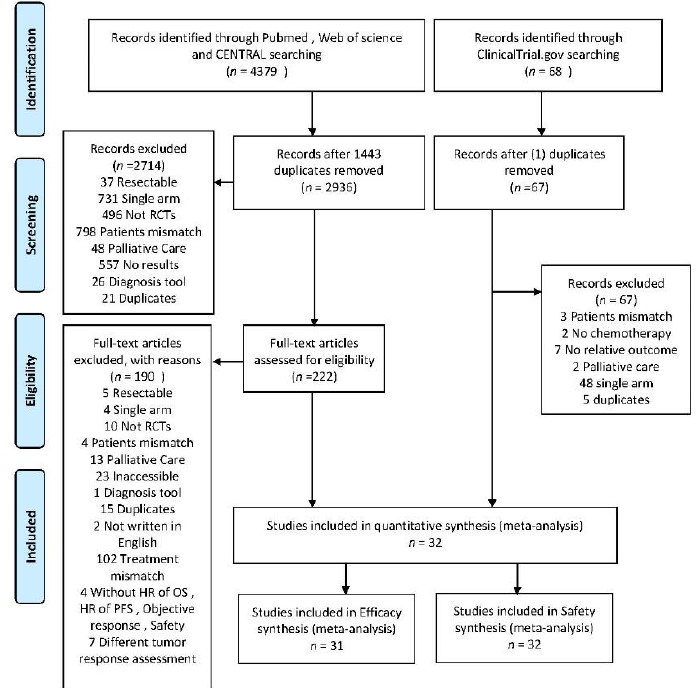
Figure 1. PRISMA flow diagram of randomized controlled trials included and excluded.